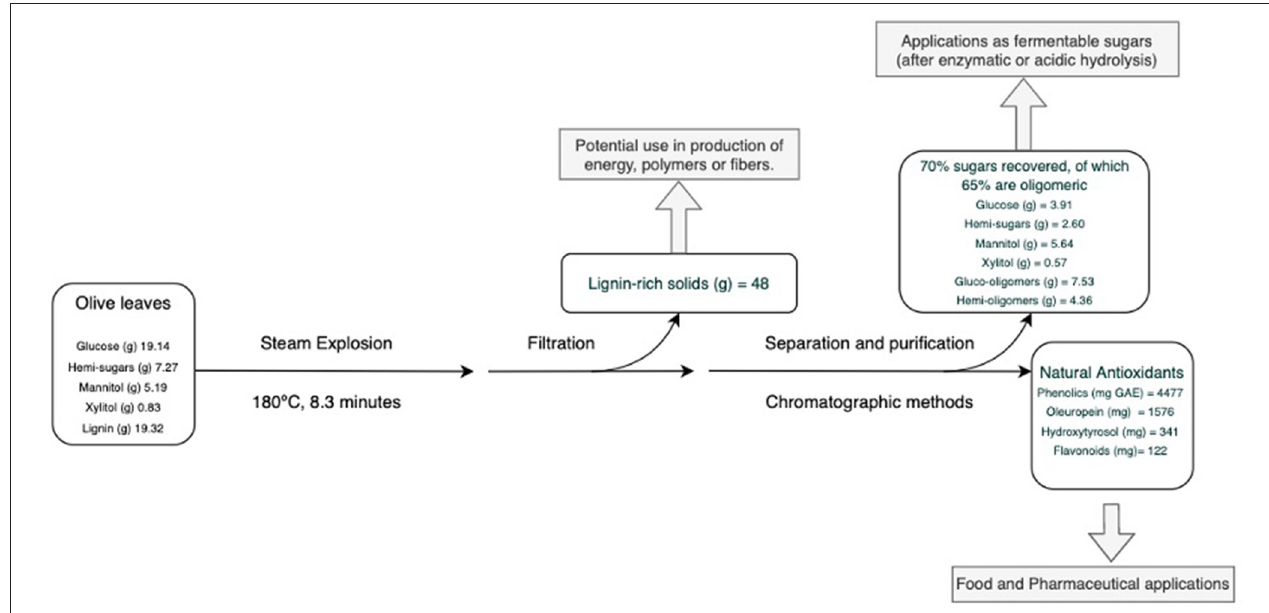
FIGURE 4 | A schematic adapted from Romero-García et al. (2016) which aims to show a process in which all by-products are utilized.